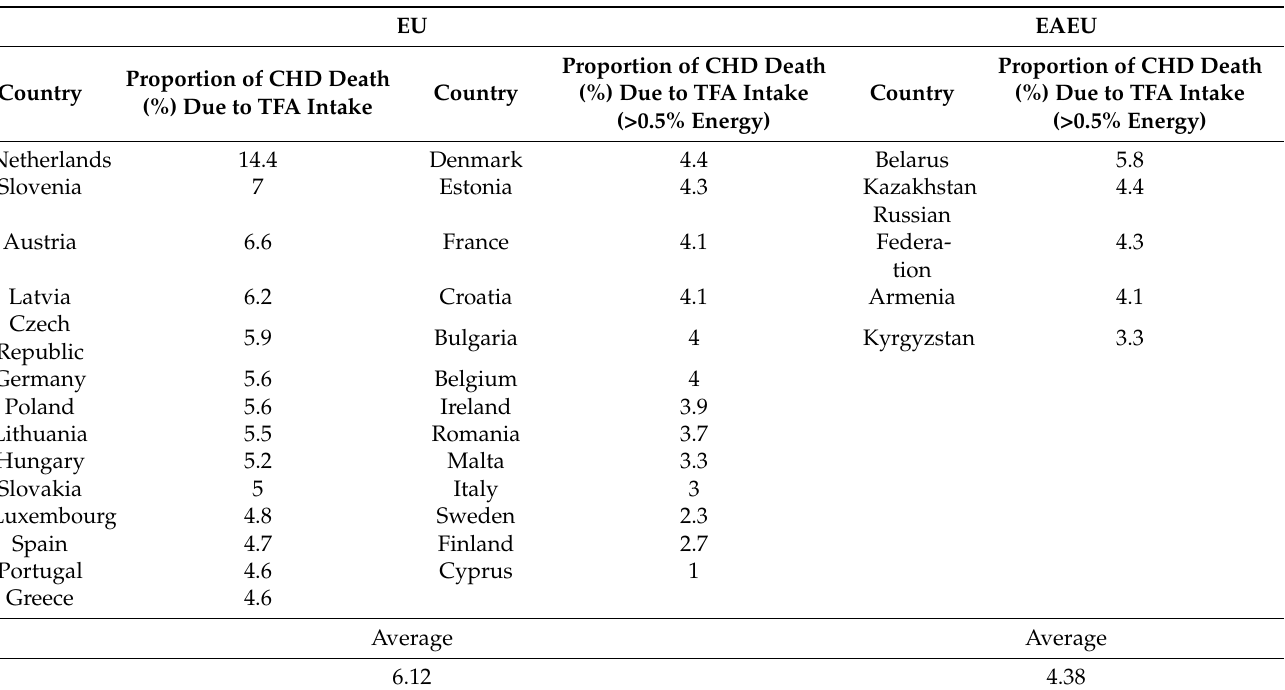
Table 2. Proportion of coronary heart disease death (%) due to TFA intake (>0.5% energy). EU